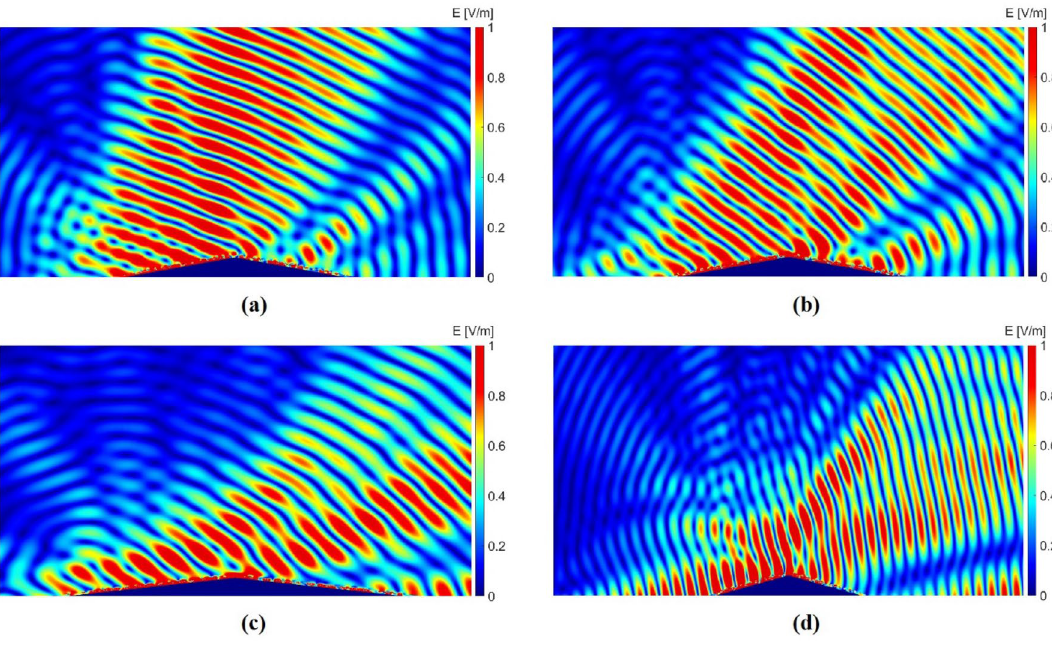
Figure 5. Reflected electric field distributions for the cloaked bump under Gaussian wave incidence with incident angles of ( a ) 25°, ( b ) 40°, ( c ) 55°, and ( d )